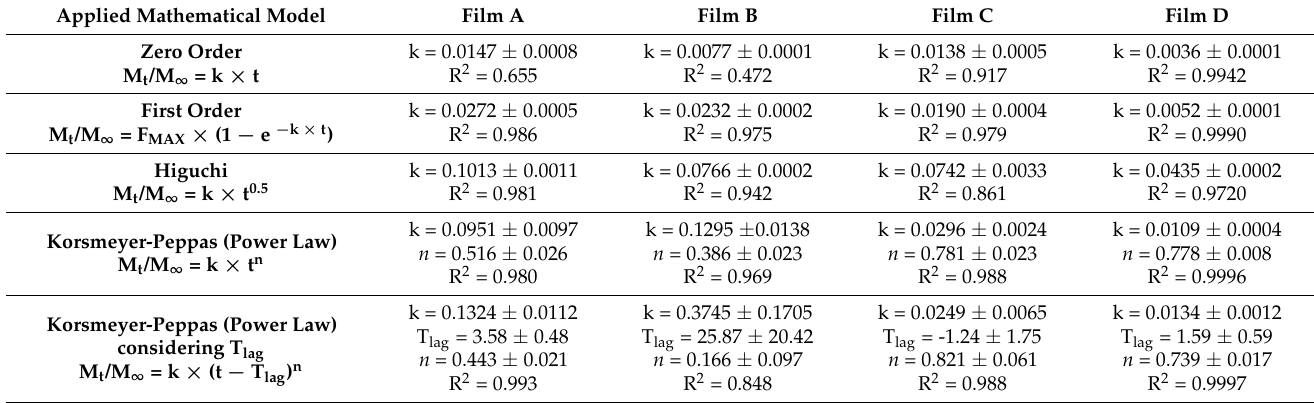
Table 6. Mathematical models fitted to the experimental release data: calculated fitting parameters and square of correlation coefficient (R 2 ). Data were fitted until the 80% of CYT released (Film A, Film B and Film C, respectively) or the 60% of CYT released (Film D).